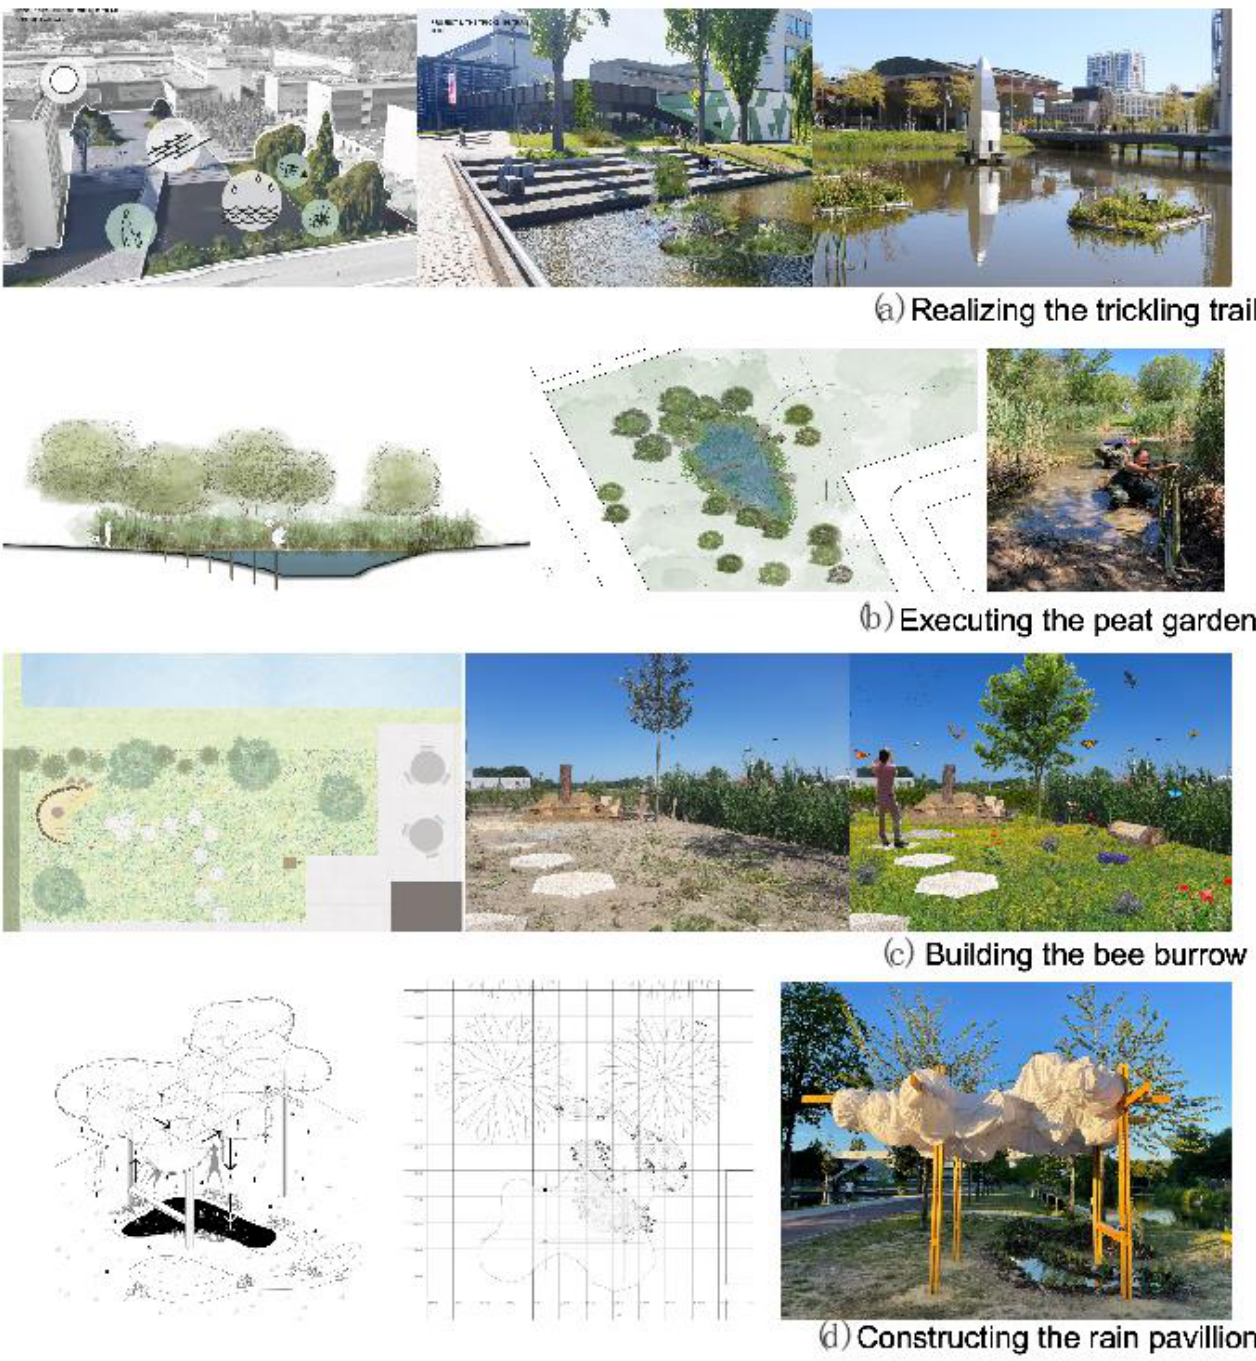
Figure 3. Four examples of built projects from design to visualization to realization: ( a ) Trickling trail, ( b ) Peat garden, ( c ) Bee burrow and ( d ) Rain pavilion.